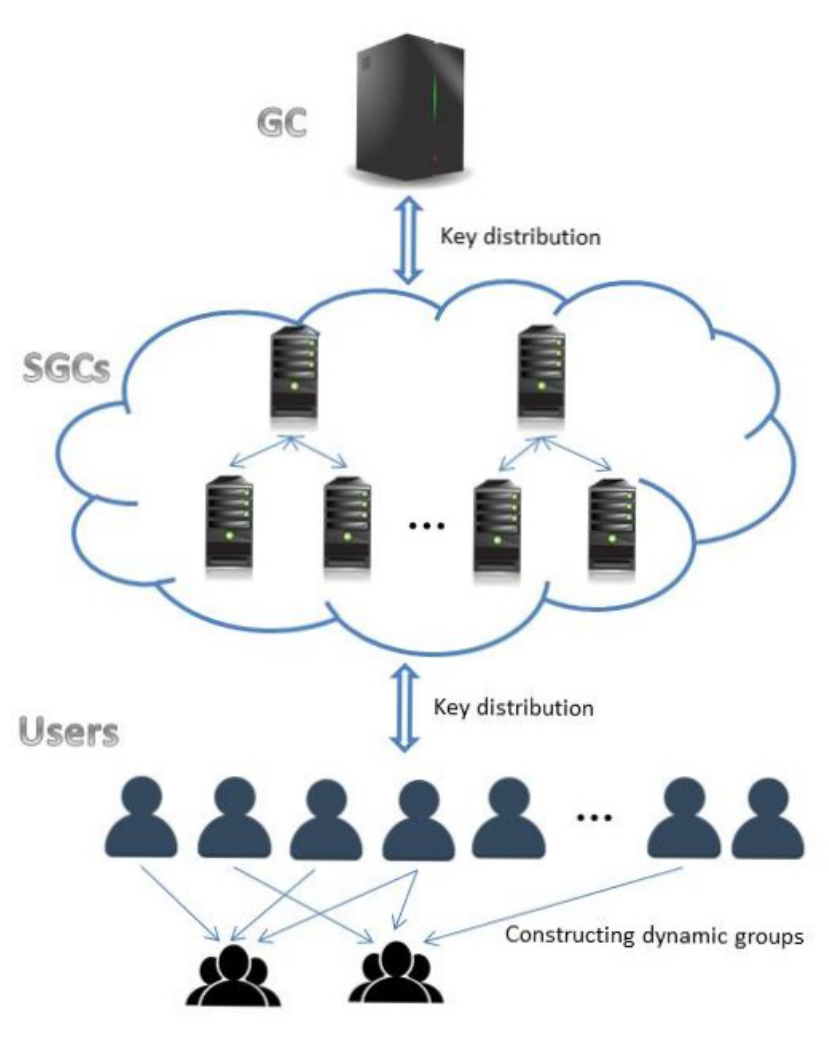
Figure 1. System